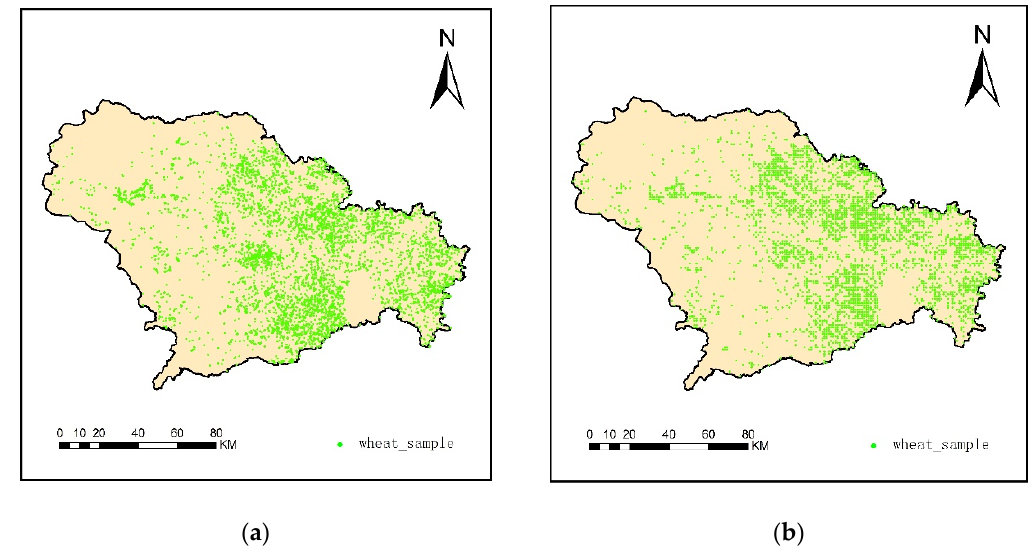
Figure 3. ( a ) Distribution of automatically extracted winter wheat sample sites in Shijiazhuang in 2018. ( b ) Distribution of automatically extracted winter wheat sample sites in Shijiazhuang in 2019.